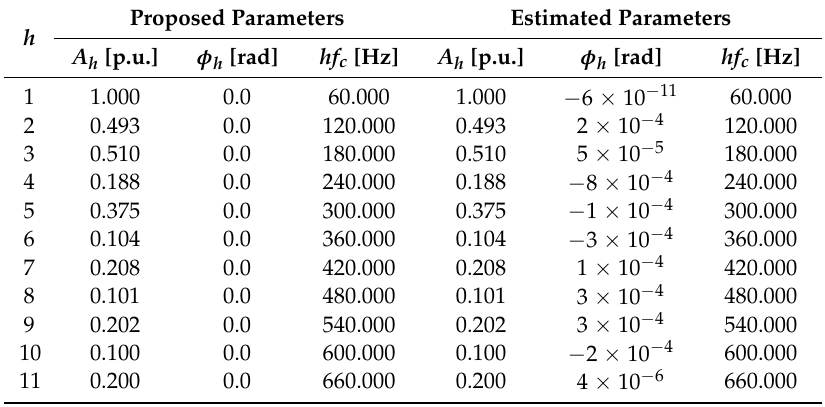
Table 1. Harmonic parameters for synthetic signals and estimated parameters by the proposed algorithm. Proposed Parameters Estimated Parameters h A h